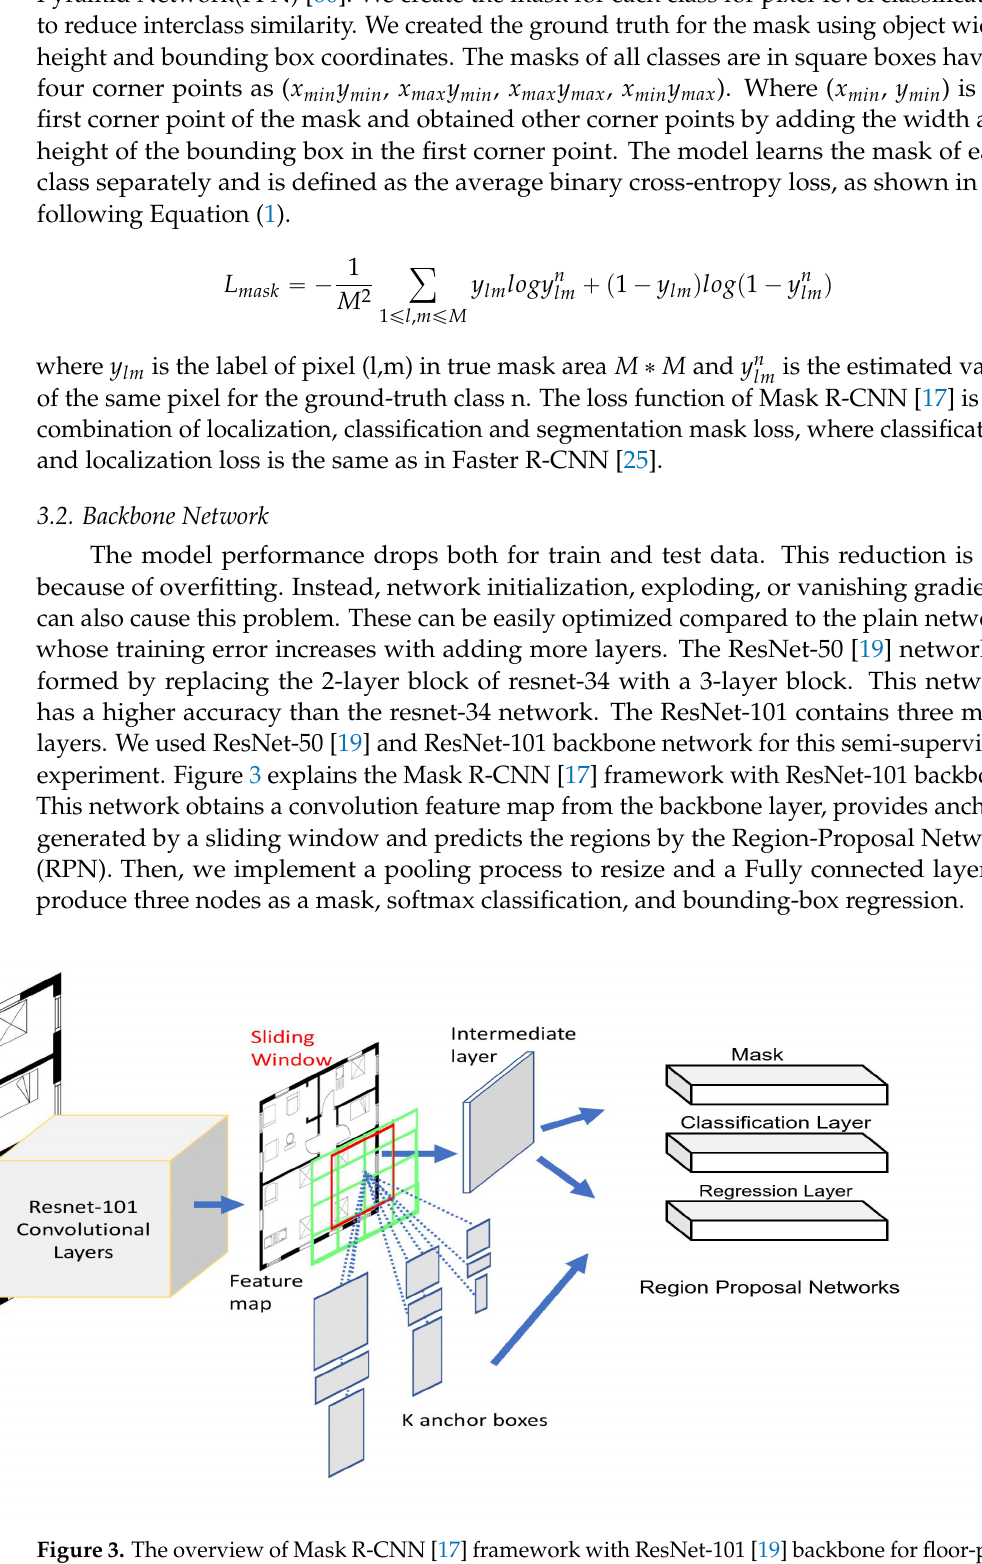
Figure 3. The overview of Mask R-CNN [17] framework with ResNet-101 [19] backbone for floor-plan object